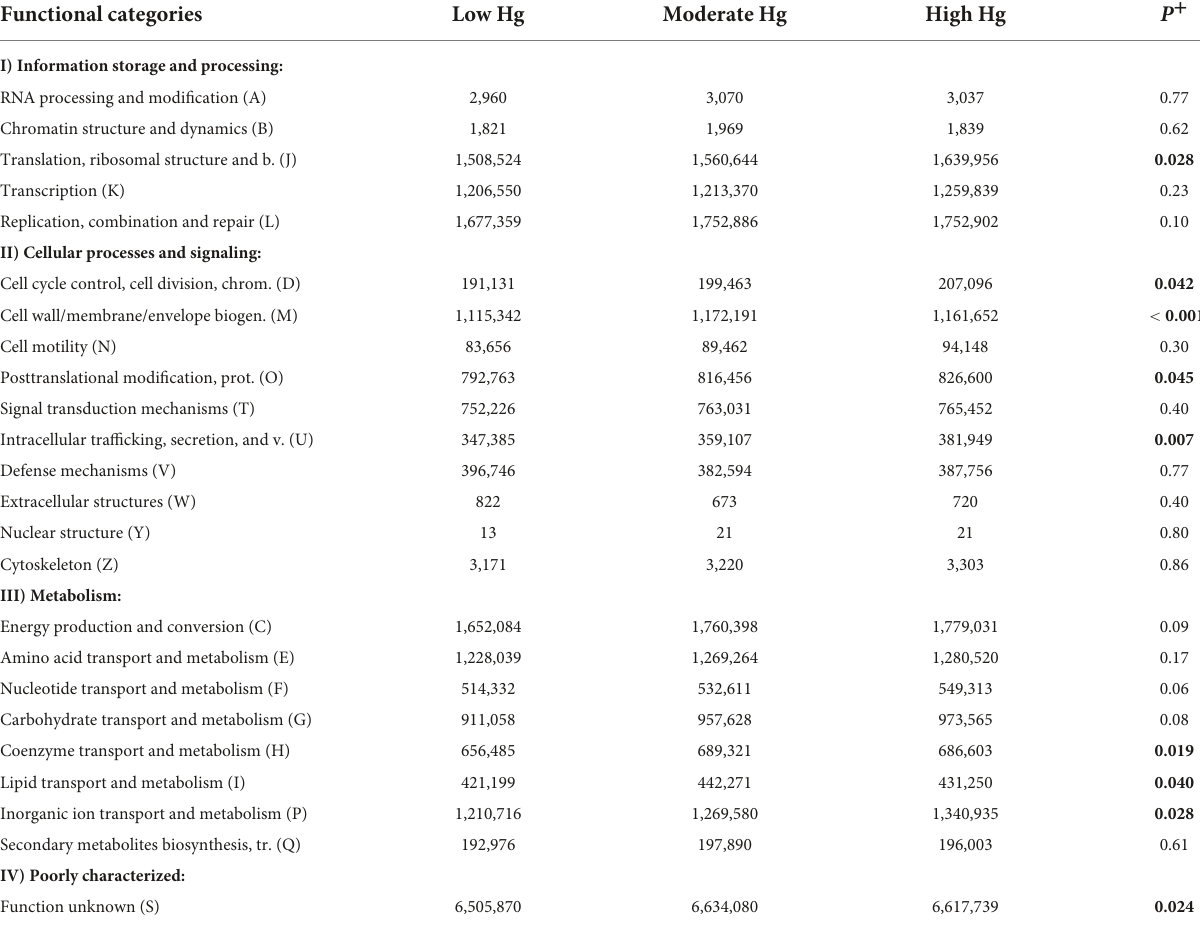
TABLE 5 Normalized counts of genes of the EggNOG database of soils with the three different Hg contamination levels ( n = 3). Functional